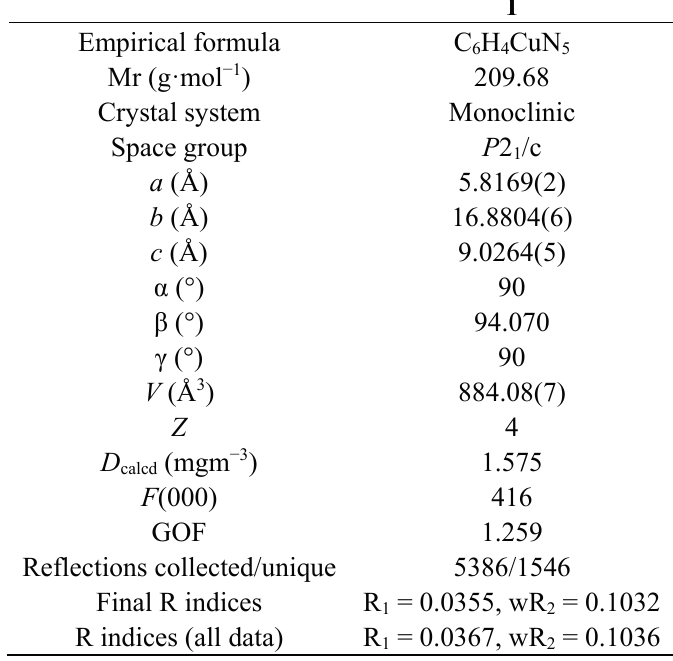
Table 3. Crystallographic data and refinement details for 1